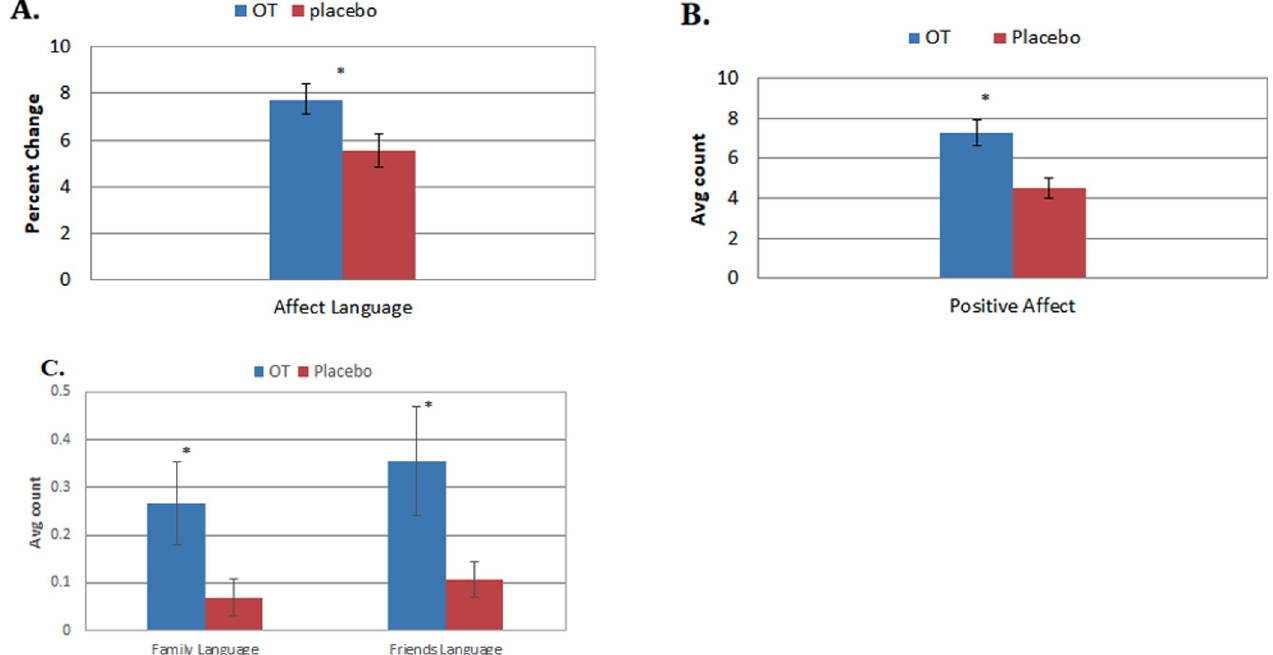
Fig 2. The effects of OT when writing about brands with standard errors. A. OT increased the use of affective language by 39% (p = .021). B. This was driven by a 62% increase in positive affective language (p = .001). C. OT also boosted discussions of family about 286% (p = .04) and friends by 227% (p = .04) in participants’